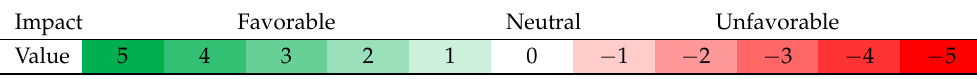
Table 3. Classification for each change impacts “scores” in every criterion of multi-criteria evaluation set.